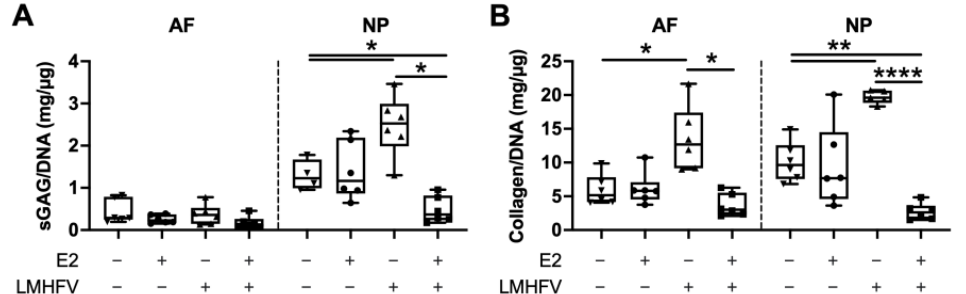
Figure 5. Protein quantification in AF and NP tissue digests of control, E2-, LMHFV- and E2 + LMHFV-treated IVD samples after 21 days of culture. ( A ) sGAG and ( B ) collagen normalised to DNA (mg/μg). Results are presented in box plots ( n = 4–6 IVDs/group). * p < 0.05, ** p < 0.01, **** p < 0.0001.